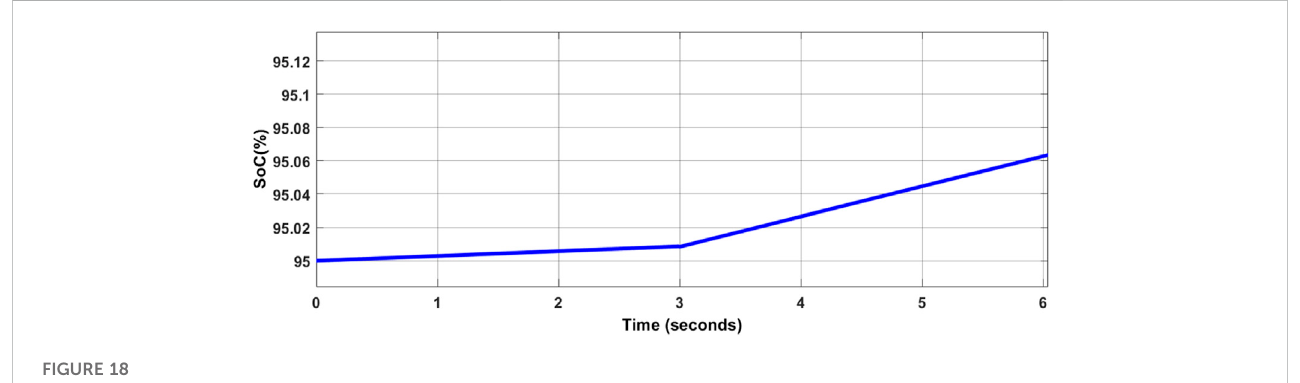
FIGURE 18 SOC of the